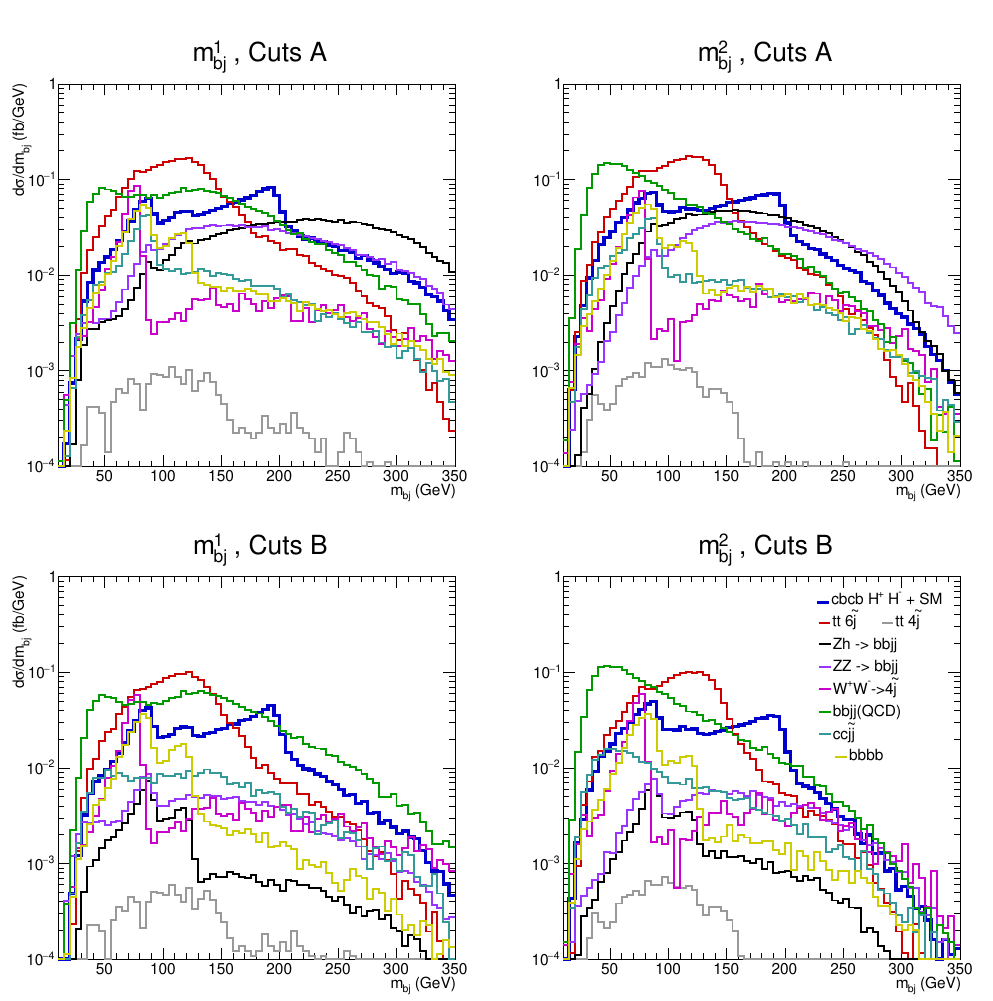
Figure 2 . Reconstructed m bj from both bj pairs, following Cuts A and B. See text for more details.